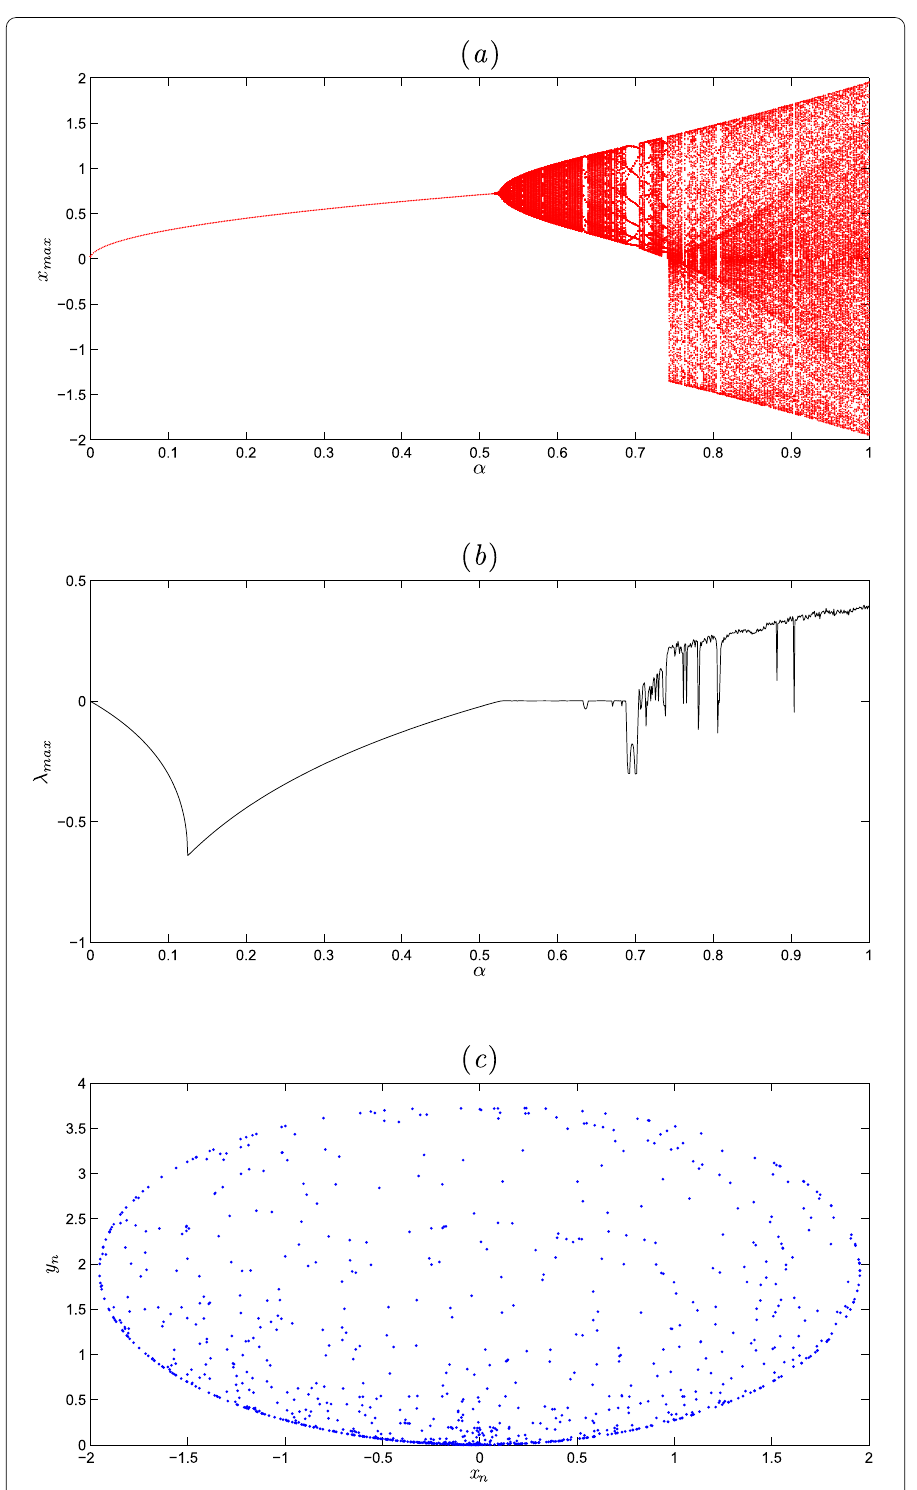
Figure 1 Bifurcation and the LLE diagrams of the 2D-FoLDS versus α , for system’s parameter β = 0.73 and initial condition x 0 = 0.2, y 0 = 0.3: ( a ) bifurcation diagram and ( b ) LLE. ( c ) Chaotic attractor of the 2D-FoLDS for α = 1, β = 0.75 and ν =